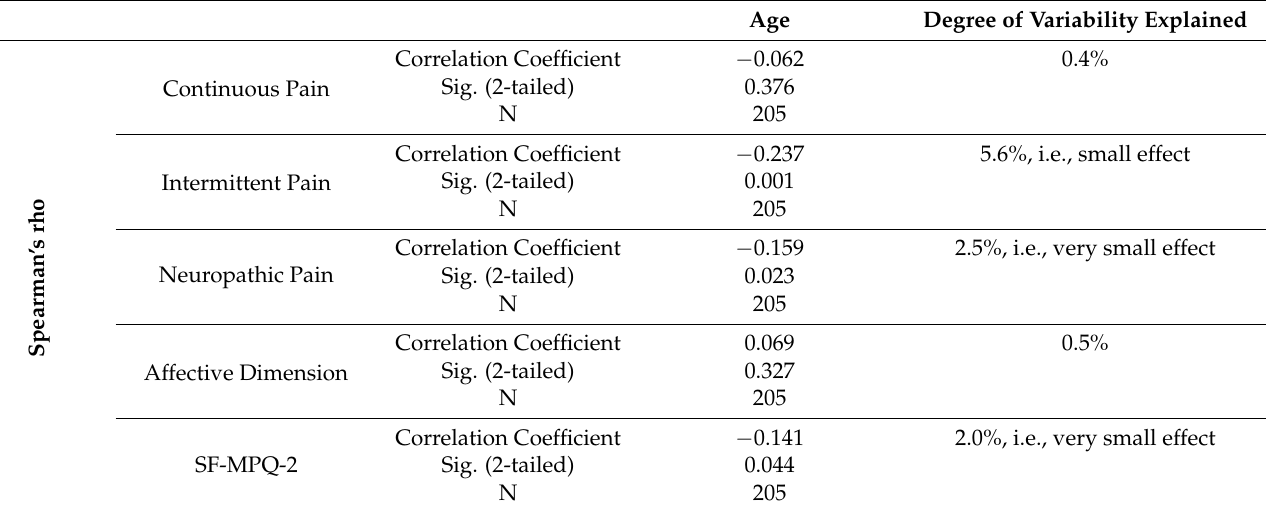
Table 5. Association of the total SF-MPQ-2 score with patient age.